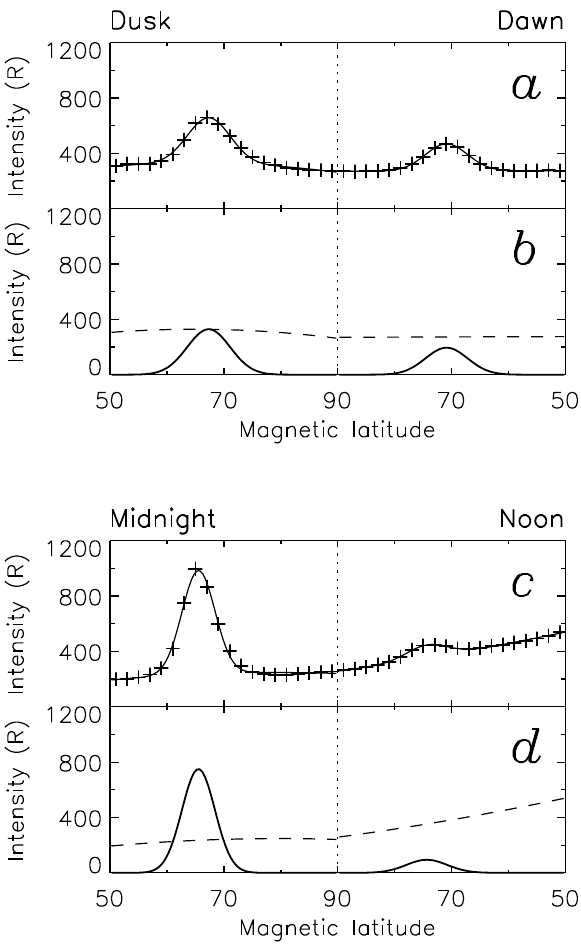
Fig. 4. Illustrative of the fitting technique used to find the Gaussian auroral profile (solid curves) and a polynomial background (dashed curves) corresponding to the raw average intensity profiles (crosses) along the dawn-dusk and noon-midnight meridians of an SI12 im-